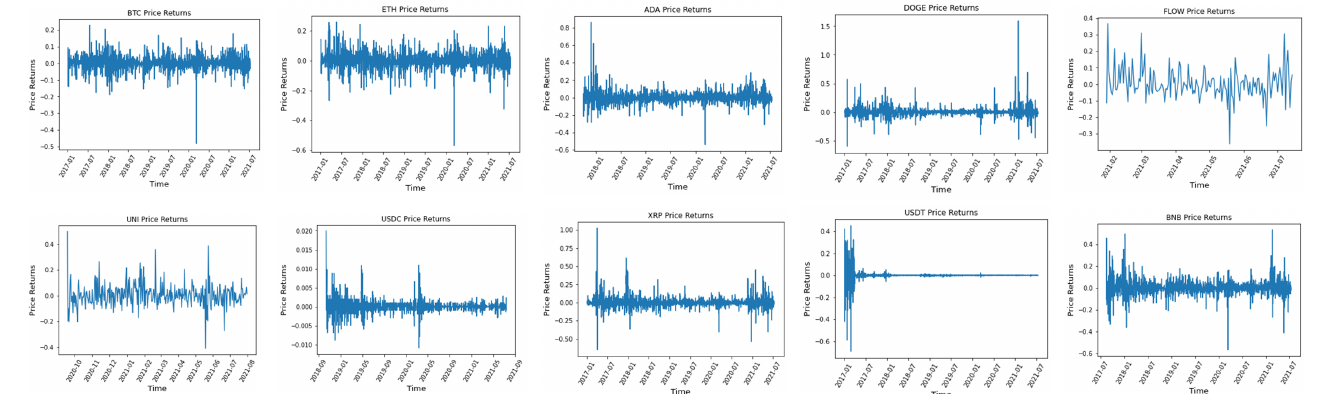
Figure 2. Time-series plot of price log returns of 10 cryptocurrencies. Figure 3 shows a heat map of the relationships between the price log returns of cryptocurrencies. BTC and USDT are the only cryptocurrencies that have mostly negative correlations with the other cryptocurrencies in terms of price log returns. This may be due to USDT being a stable cryptocurrency, so when the prices of BTC or other Altcoins collapsed, investors moved to the stable cryptocurrency to hedge their investment in the cryptocurrencies. The other cryptocurrencies have moderate correlation with one